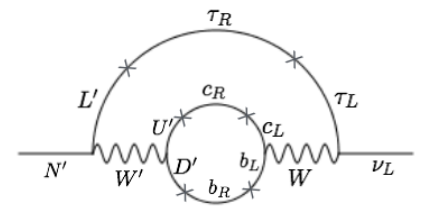
Figure 4 . The two loop contribution to Dirac mass for neutrinos. Crosses on fermion propagators denote mass insertions from h H V i or h H i , as inferred from the Lagrangian.